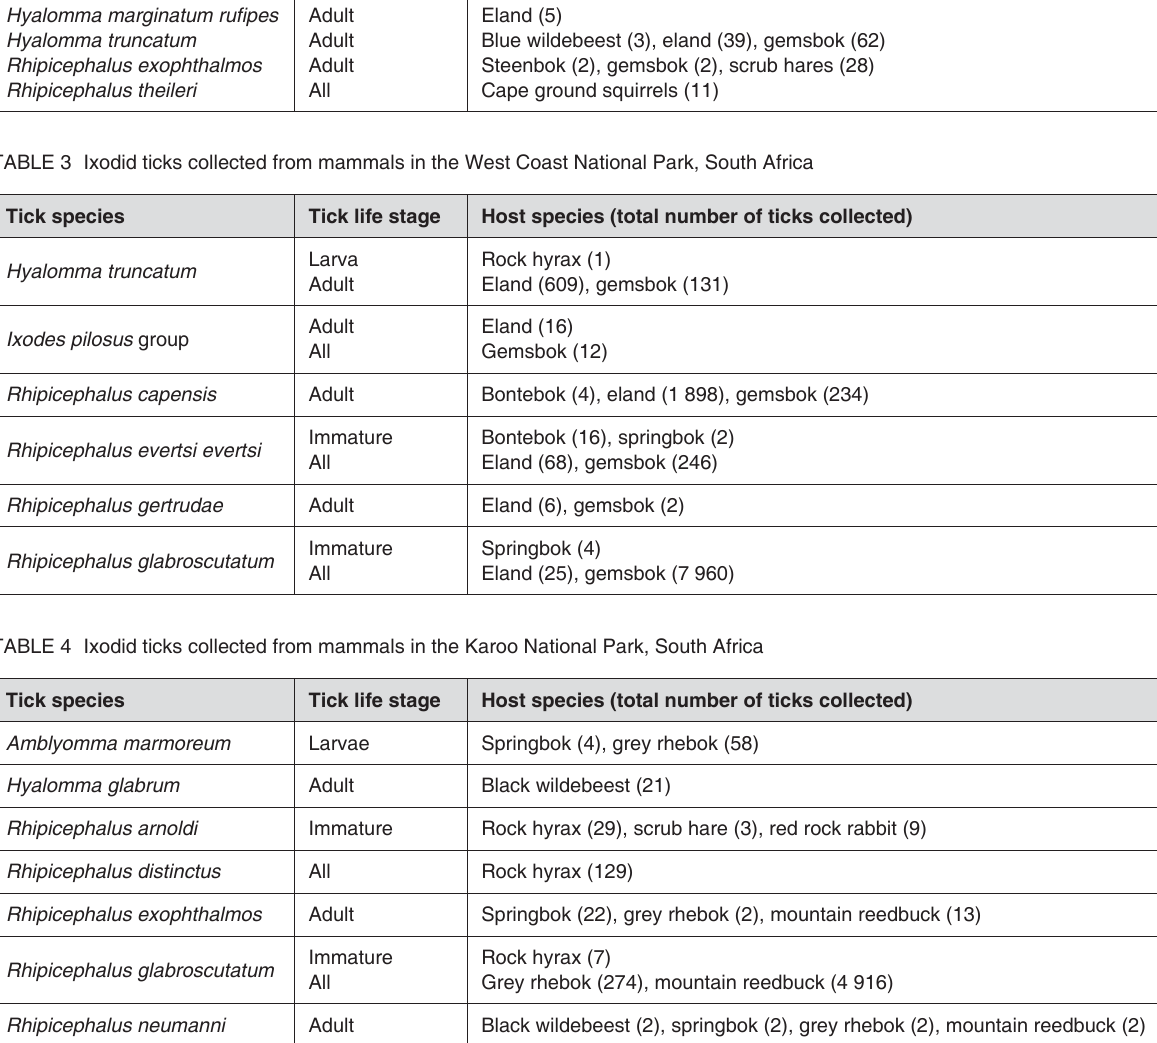
TABLE 2 Ixodid ticks collected from mammals in the South African part of the Kgalagadi Transfrontier Park Tick species